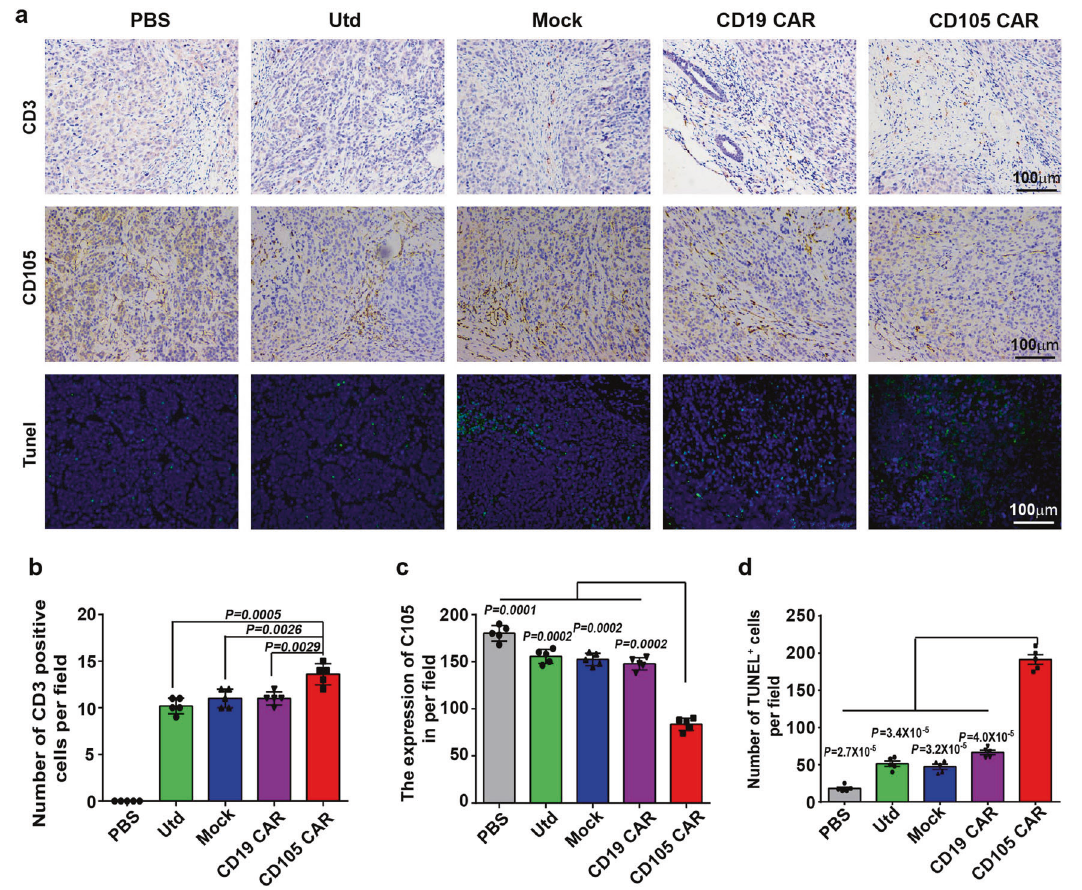
Fig. 7 Treatment with anti-CD105 CAR-T cells increased T-cell tumor in fi ltration, reduced the CD105 expression in the tumor tissues, and increased tumor cells apoptosis. a Tumors were collected from mice bearing Bel7404 subcutaneous xenografts treated with CD105 CAR, CD19 CAR, Mock, Utd, or PBS. Formalin- fi xed, paraf fi n-embedded tumor sections were consecutively cut and stained for human CD3 expression, CD105 expression, and TUNEL assays. b Quantitative analysis of T-cell in fi ltrates in tumor tissues. c Quantitative analysis of the CD105 expression. d Quantitative analysis of apoptotic cells. Data are representative images (magni fi cation ×100) or expressed as the mean ± SD from fi ve randomly selected fi elds of tumor thin sections. The quantitative analysis was used by one-way ANOVA with multiple comparisons